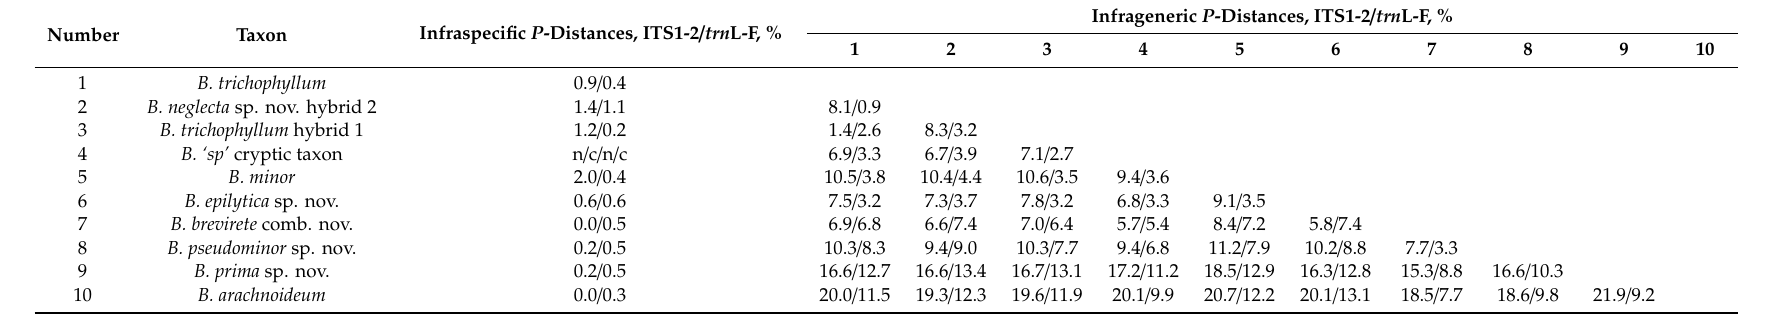
Table 3. The value of the ITS1-2 / trn L-F p -distances for the genus Blepharostoma , n / c—non-calculated value due to a single studied